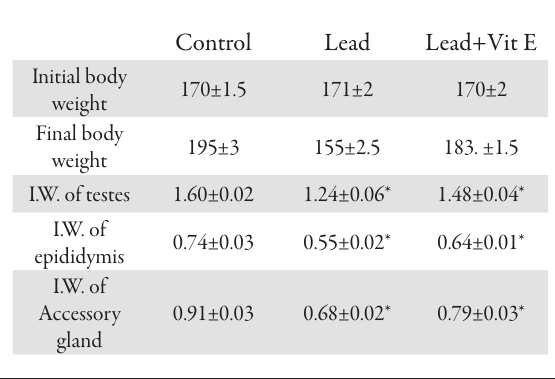
Tab. 1. Effect of lead and its combination with Vit E on body weight and reproductive organs weights of male rats